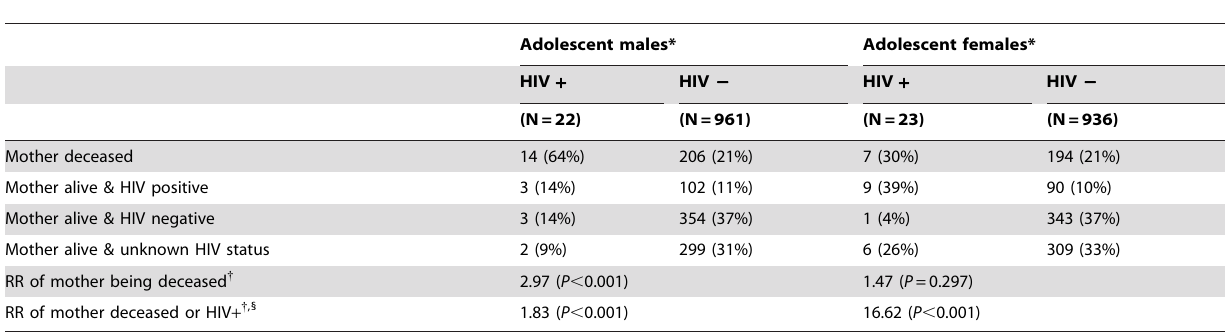
Table 2. Maternal mortality and HIV status by adolescent HIV status.